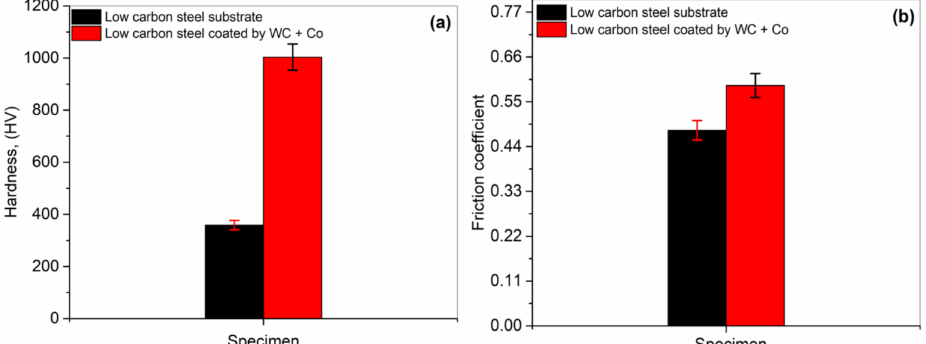
Figure 9. Comparison of the ( a ) hardness and ( b ) friction coefficient, with and without coatings; based on the data from